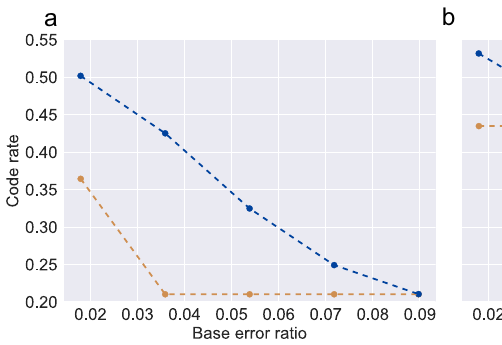
Fig. 2 | Code rate comparison: required code rate (information nucleotides divided by total nucleotides encoded) for successful decoding 100 out of 100 triesforagiven BER.a using theoutputconstraintsofaGCcontentof40 – 60% in 10 bp long intervals and a maximum homopolymer length of 3, b with output